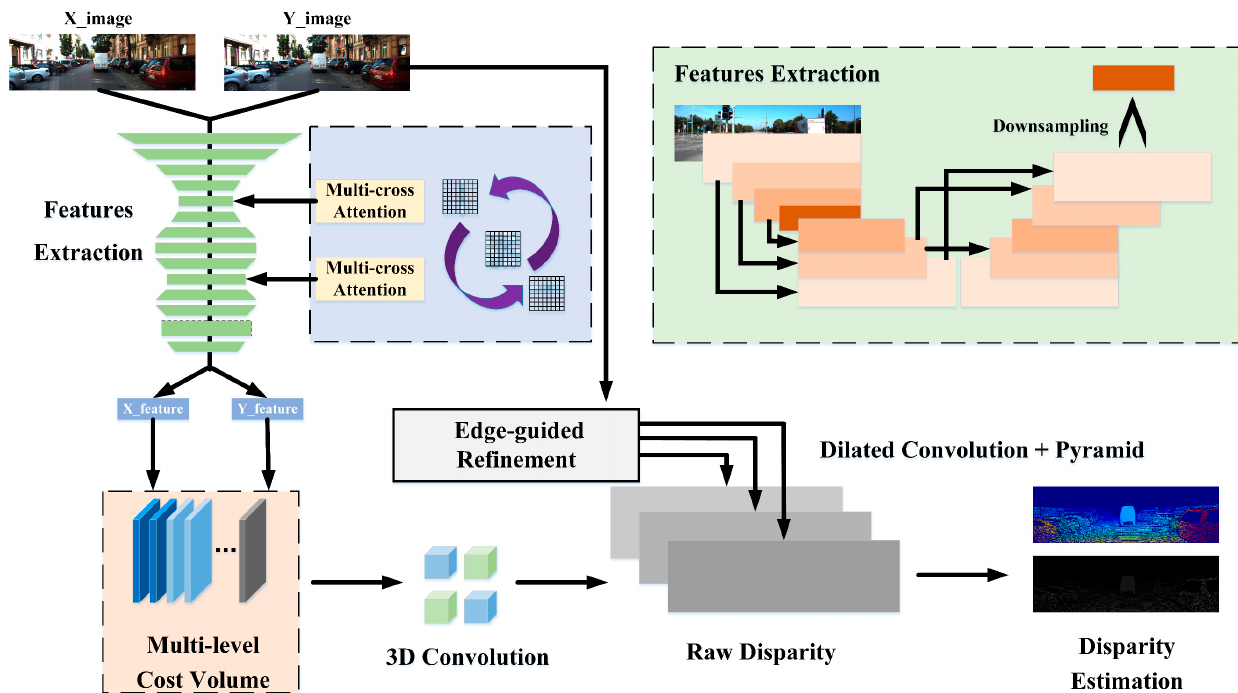
Figure 2. Our network structure. It consists of a feature extraction layer with multi-cross attention, multi-level cost volume layer, 3D convolutional layer, and edge-guided optimization network. First, the input is the left and right matching image pairs with the correction of the input pole line. The next layer is a stacked hourglass feature extractor that provides a down-samping low-resolution feature image. The features of the binocular images are fully extracted by this layer with shared weight [32], and two corresponding feature images of the binocular are obtained. At the same time, the purple part is the multi-cross attention module, which is placed before the convolutional layer of the feature extractor to improve the ability. Then we combine the left and the right feature images into a whole through a multi-level cost volume layer. The two feature images form a multi-level cost volume of 96 channels to improve the accuracy. Next, the raw disparity predictions are regressed by the cost volume through the 3D convolutional layer. Finally, we optimize the efficient disparity image by the edge guidance of the RGB image through the optimization network.